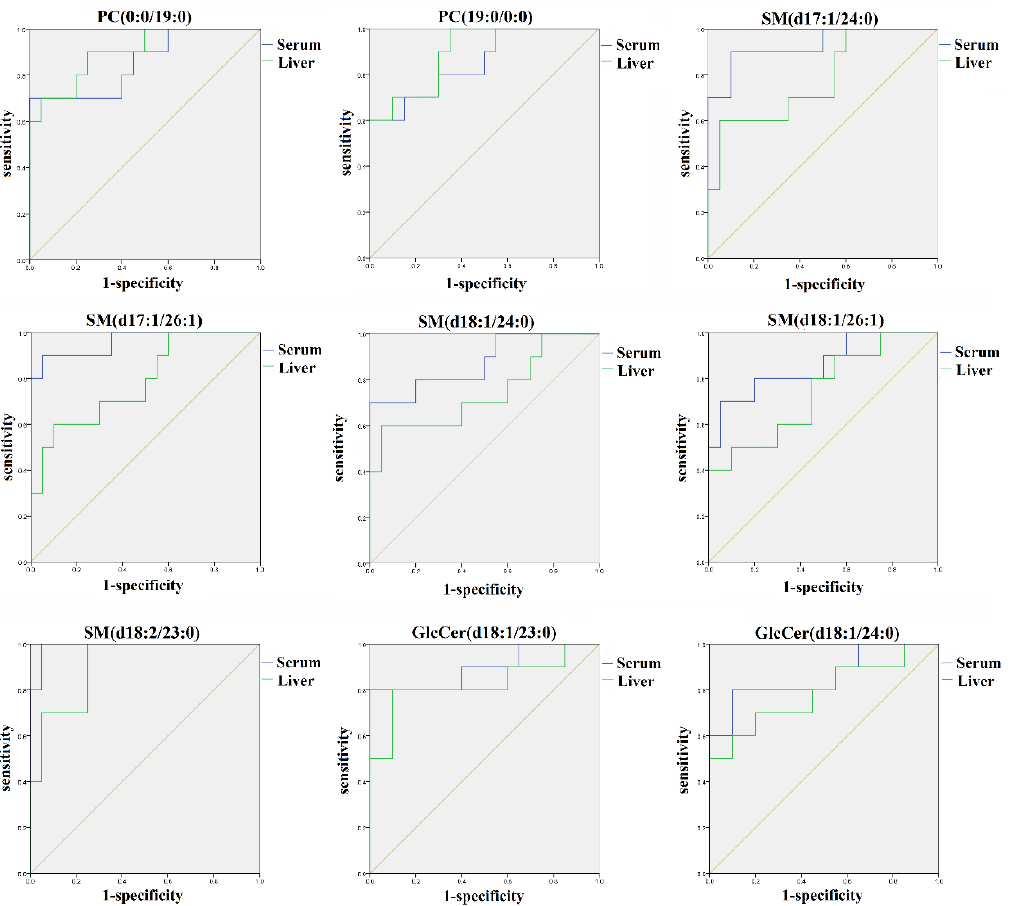
Figure 5. Receiver operating characteristic (ROC) curves of nine out of 26 common lipids from the control group, AAI group, and one-week group based on OPLS-DA analysis. The associated AUC, specificity, and sensitivity values of five SMs, two PCs, and two GlcCers were exhibited.